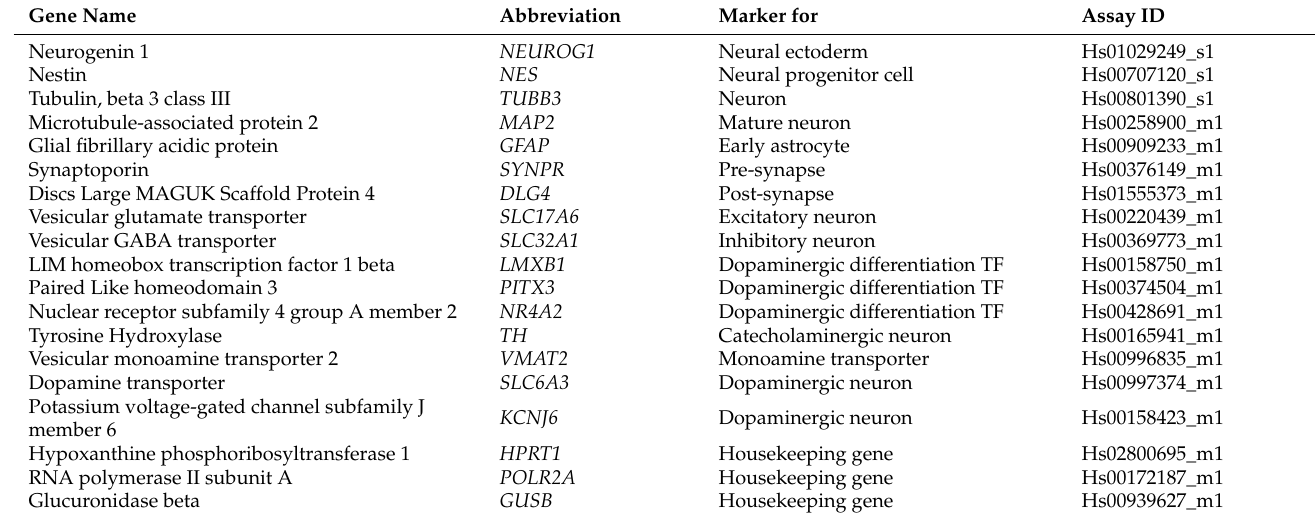
Table 1. Primers used for gene expression experiments with corresponding marker function and assay ID. All primers were purchased at Applied Biosystems. TF: transcription factor.